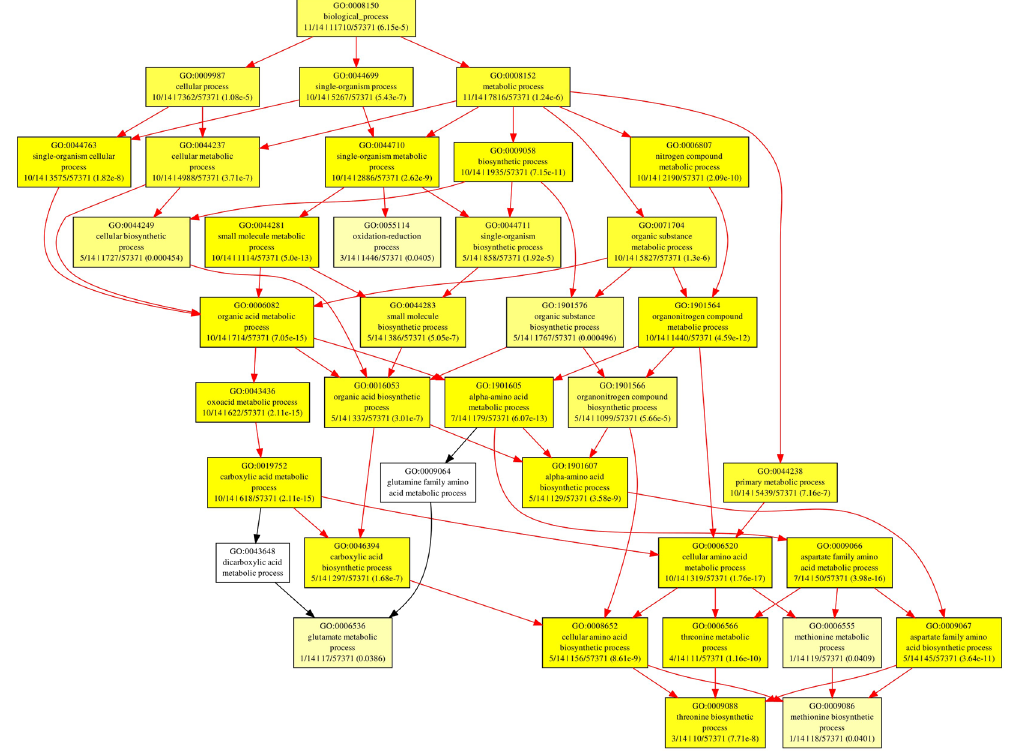
Figure 8. Classification of AbSR -ThrMPG based on their biological process. Boxes represent GO terms, term definition, labelled by its GO ID, and detailed information, organized as ‘q/m|t/k ( P -value)’ (‘k’- genes from microarray; ‘t’- microarray with total of genes; ‘q’- genes within ‘k’; ‘m’– genes within ‘t’ associated with it. The GO enrichment analysis formula adopted from Zheng and Wang, 2008). Yellow color boxes indicate significantly enriched GO terms. The level of color saturation of each node is positively correlated to the significant level of the corresponding GO term. White color boxes represent non – significant GO terms within the hierarchical tree. Arrows signify the connections between different GO terms. Red color arrows indicates relationships between two enriched GO terms, black color arrows represent relationships between enriched and un-enriched GO